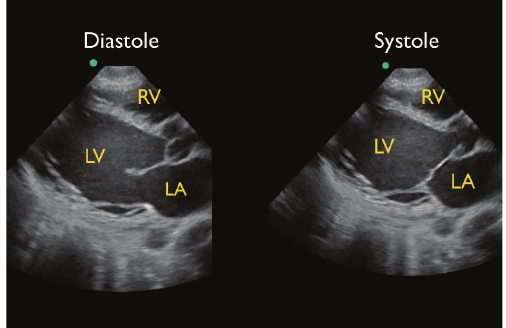
Figure 7: Poor left ventricular contractility, parasternal long axis view. RV: right ventricle, LV: left ventricle, LA: left atrium.